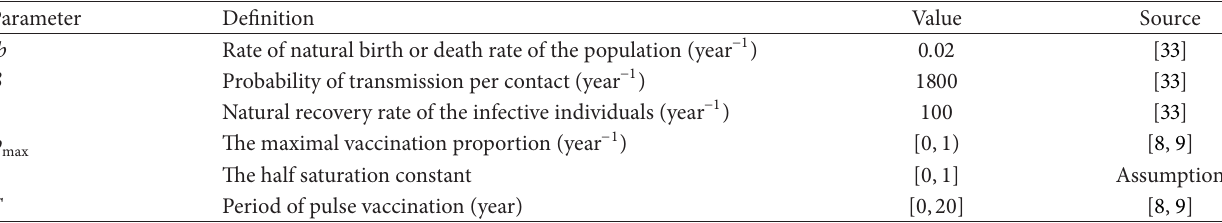
Table 1: Parameter definitions, values and source for model